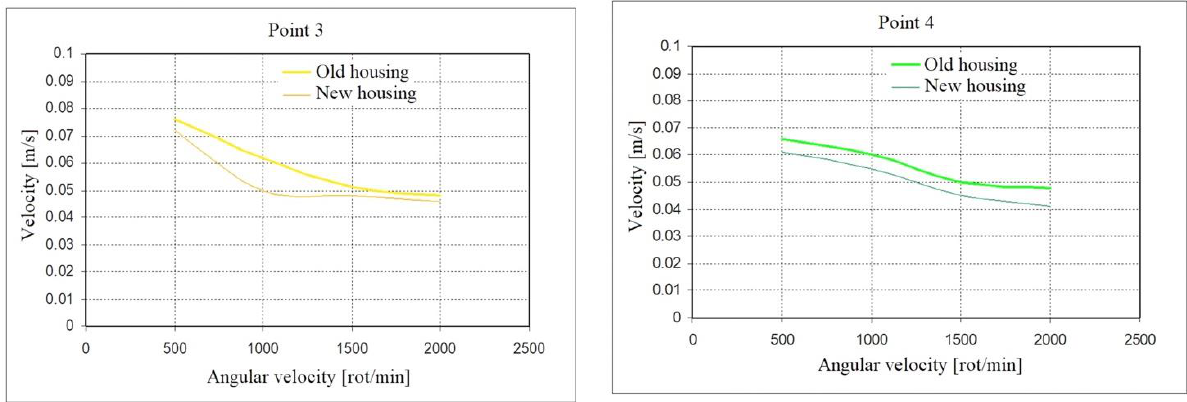
Figure 25. The velocities determined at points 3 and 4 of the two adder boxes (old and new version).